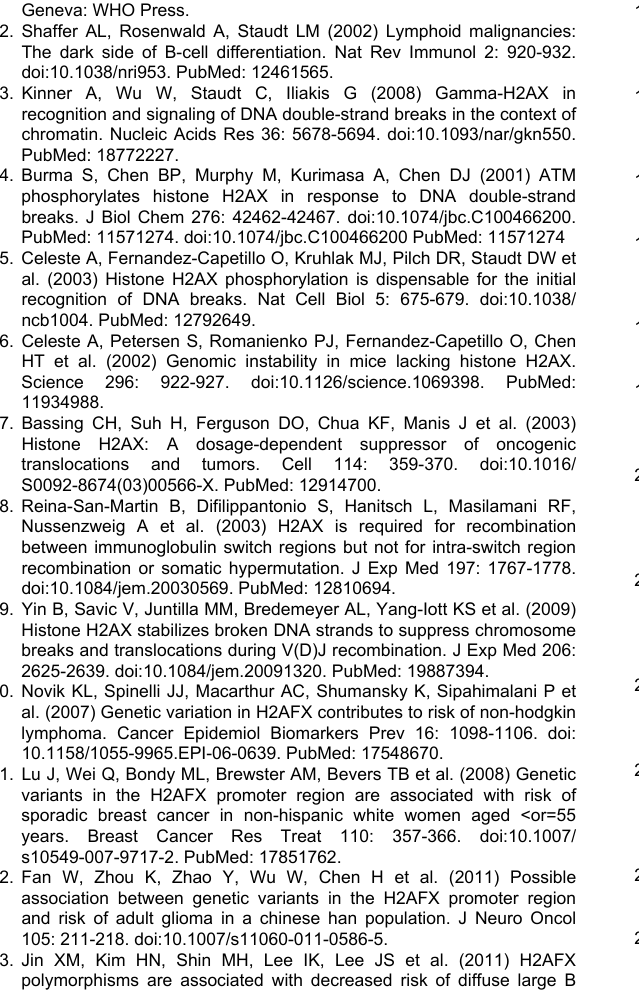
Table S1. SNPs selected for genotyping in the BC population.